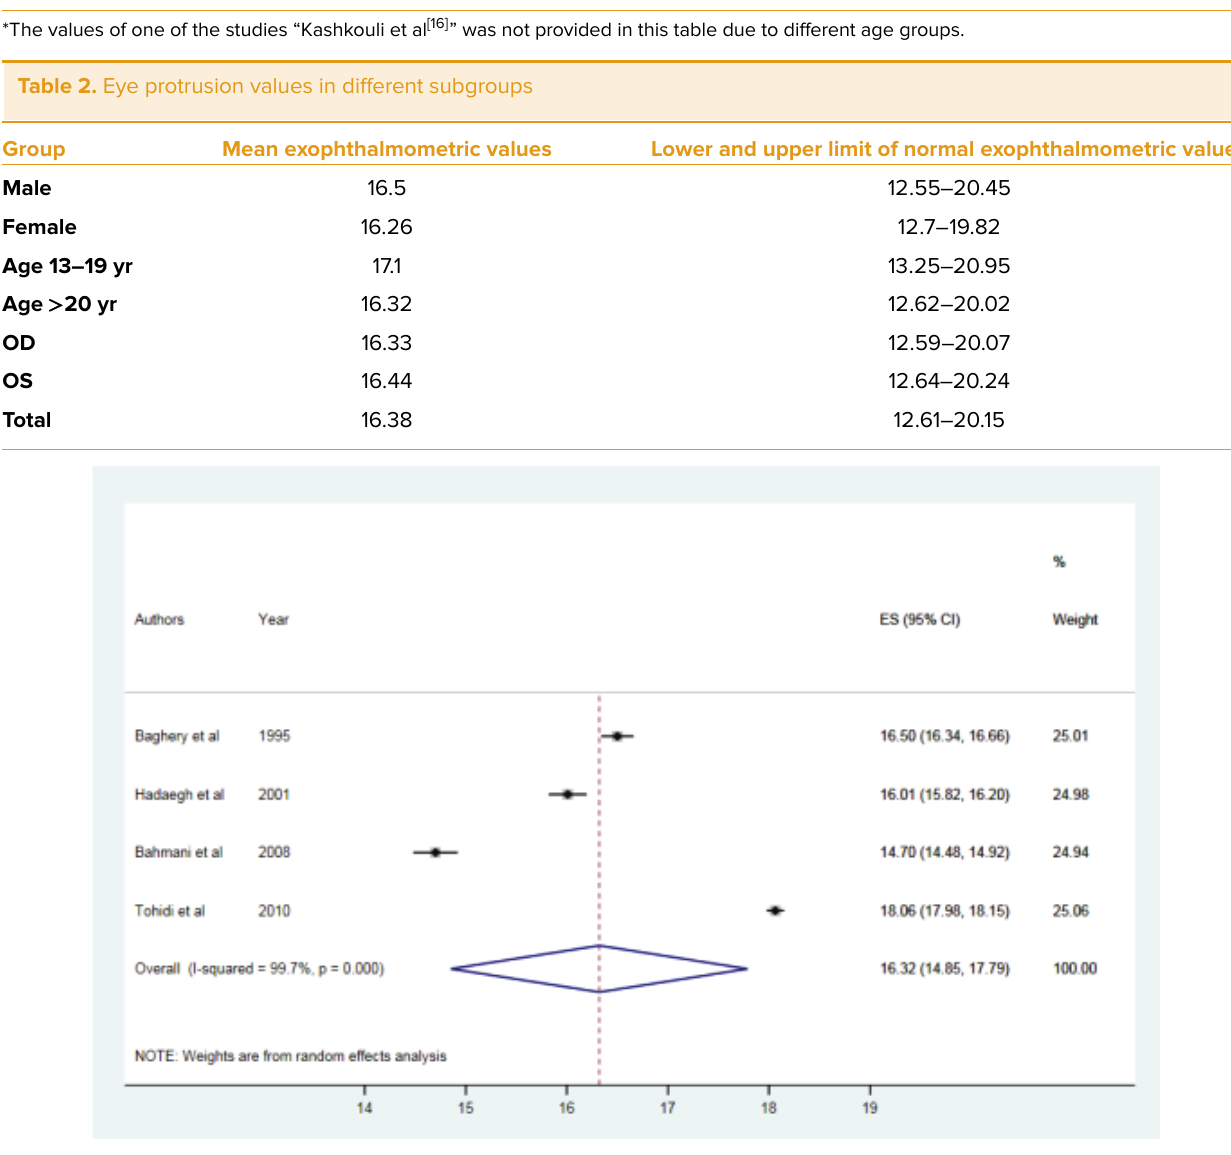
Figure 1. Mean eye protrusion in adults > 20 year